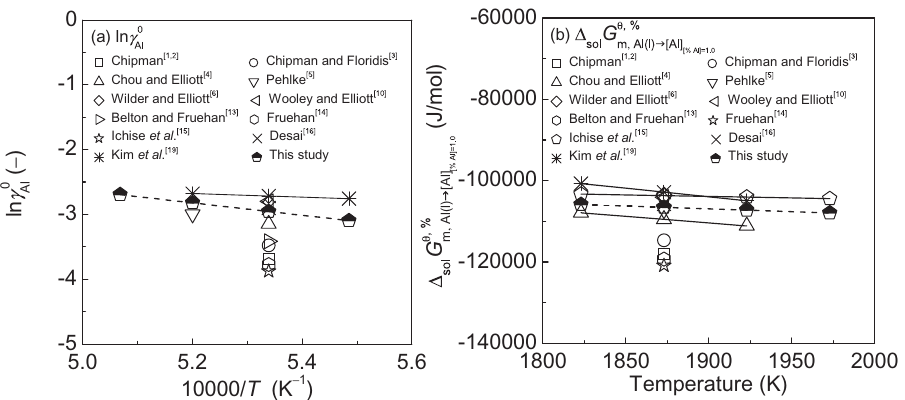
ofAlbyvariousresearcherswithobtainedonesbydevelopedAMCT – N i Al by various researchers with obtained m,Al ð l Þ!½ Al (cid:2) ½ %Al (cid:2) =1.0